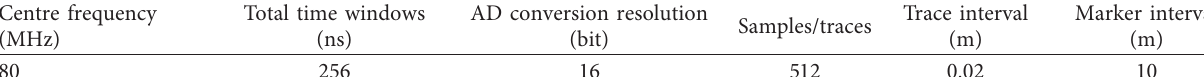
Table 3: Parameters settings of the GPR device.